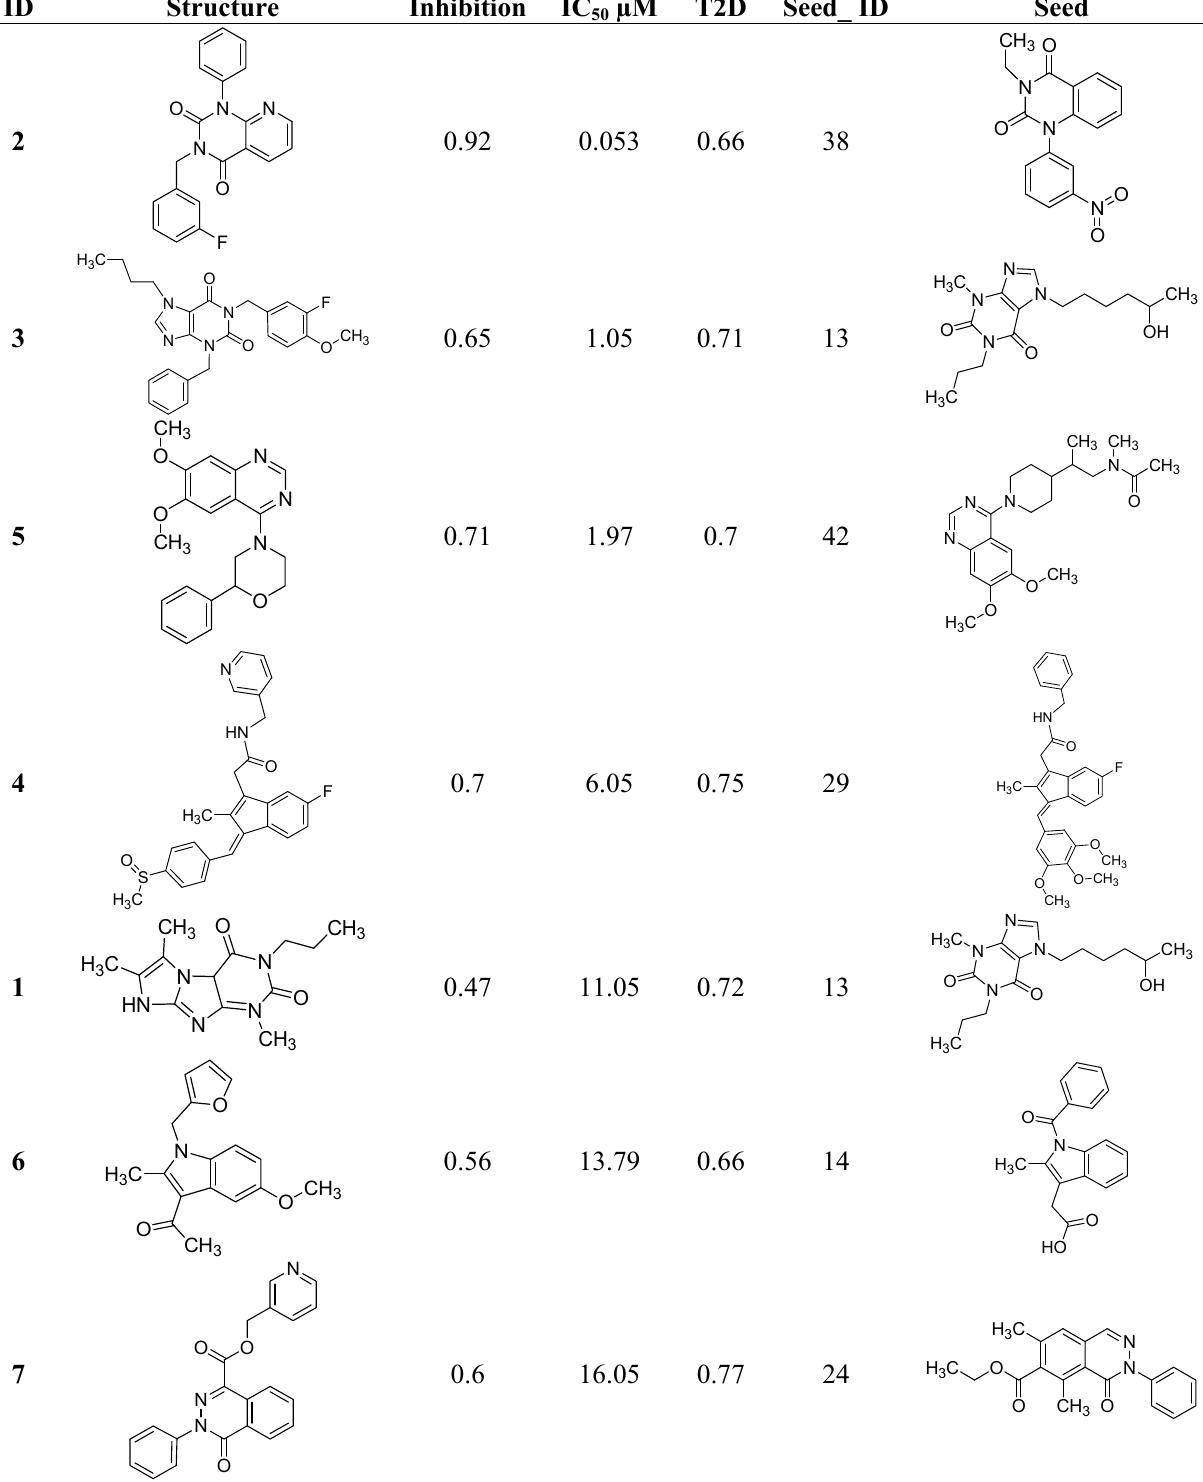
Table 2. 7 hits obtained in the first screening